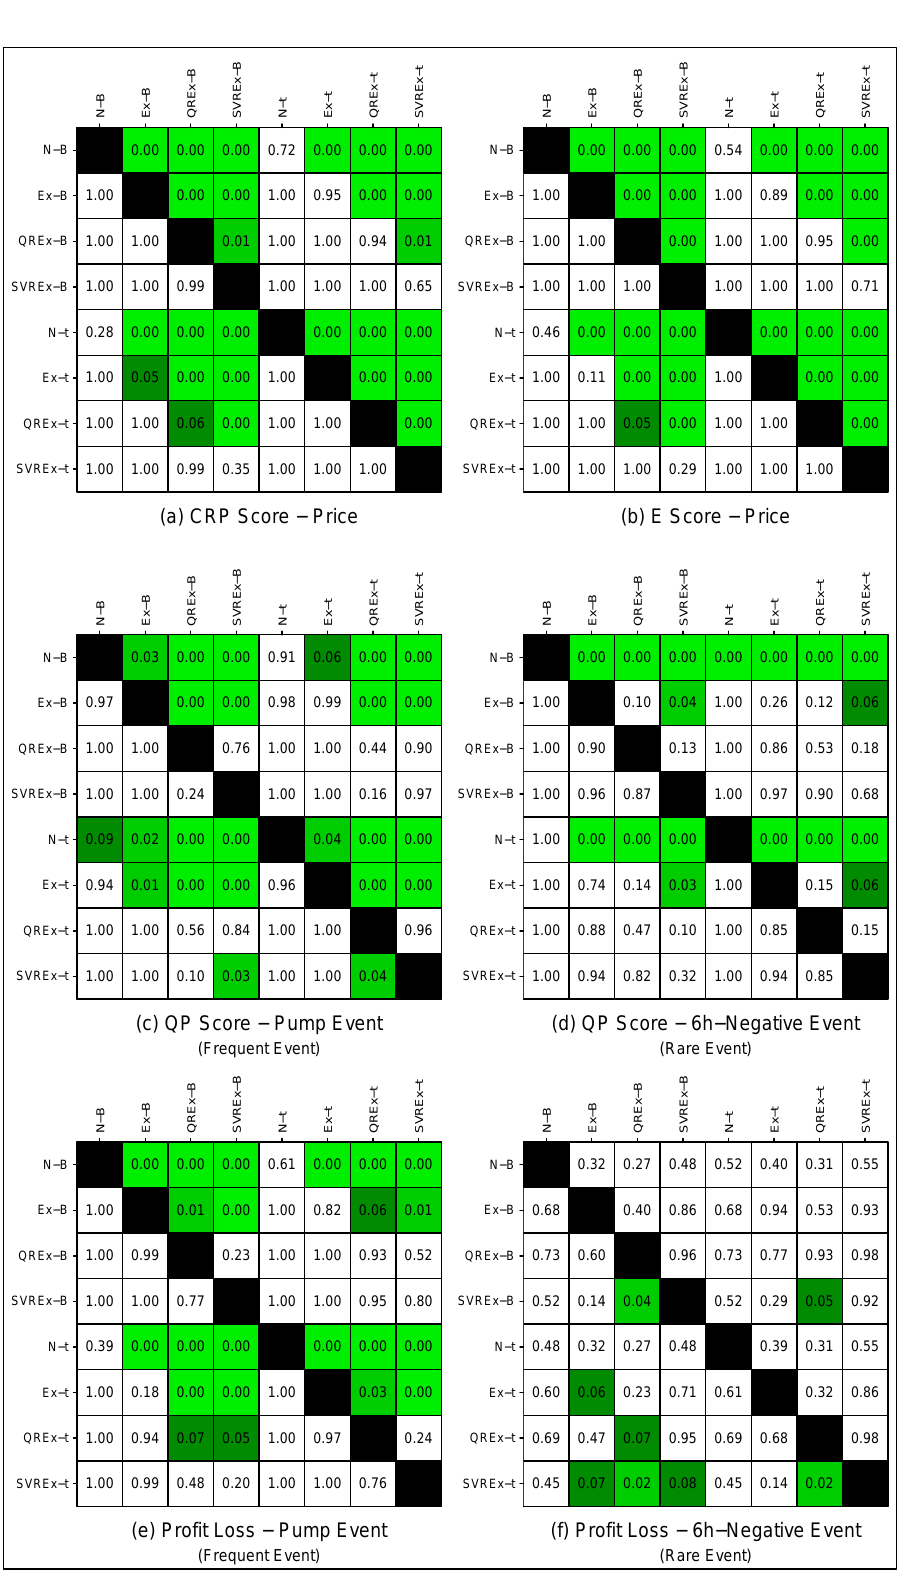
Figure 2. p -Values of pairwise DM Tests: ( a ) CRPS-based DM Tests for Electricity Price Forecasts; ( b ) ES-based DM Tests for Electricity Price Forecasts; ( c ) QPS-based DM Tests for Pump Event; ( d ) QPS-based DM Tests for 6h-Negative Event; ( e ) Profit–Loss-based DM Tests for Pump Event; ( f ) Profit–Loss-based DM Tests for 6h-Negative